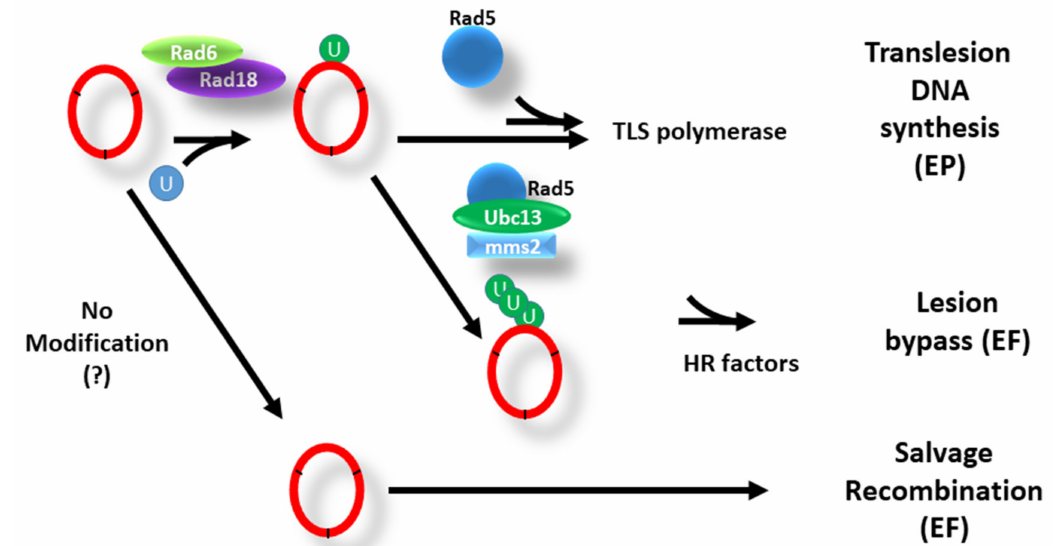
Figure 2. The DDT pathways: Representation of the four DDT (DNA Damage Tolerance) pathways. Lesions in DNA may lead to fork stalling. The damaged site can be bypassed in a mutagenic manner by recruiting an error-prone (EP) trans-lesion synthesis (TLS) polymerase. This usually requires monoubiquitination of PCNA (by Rad6/Rad18, with a still ill-understood role for Rad5), although the recruitment can be independent of PCNA modification under some circumstances. Alternatively, an error-free (EF) repair pathway is controlled by PCNA polyubiquitination, allowing a homologous recombination event using the sister chromatid that may include fork reversal. In the absence of PCNA SUMOylation, the Srs2 helicase is absent, and an error-free, homologous recombination “salvage pathway” is